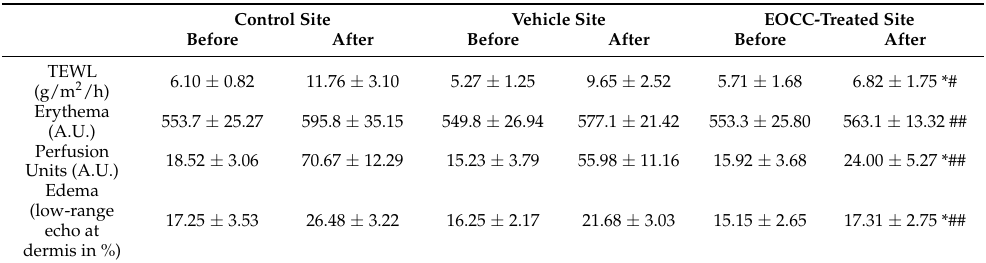
Table 3. Selected micro-inflammatory related variables (transepidermal water loss TEWL, erythema, LDF skin perfusion, and edema) measured at control, vehicle, and EOCC-treated sites before and 30 min after contact with a 0.5% methyl nicotinate solution following a 14-day pretreatment